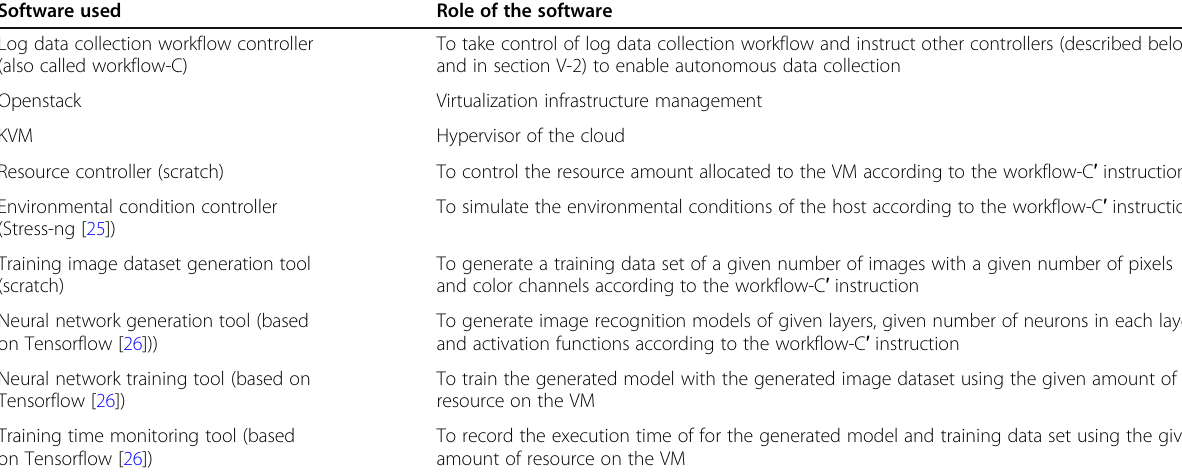
Table 4 Software used in the validation experiment Software used